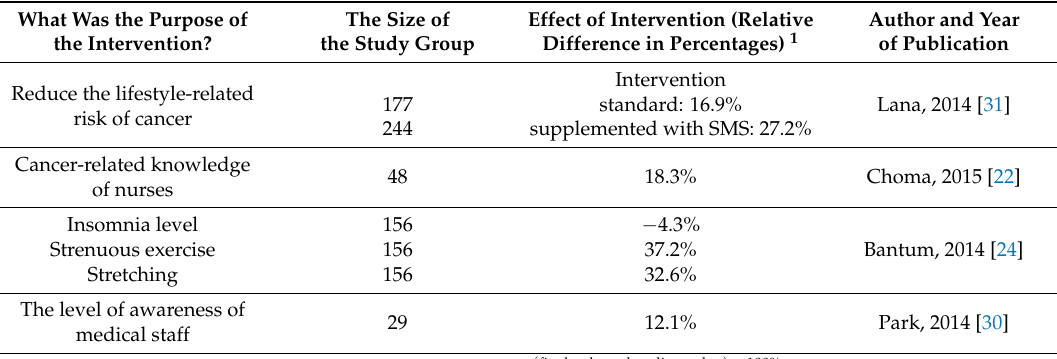
Table 4. Comparison of the effectiveness of selected web-based educational